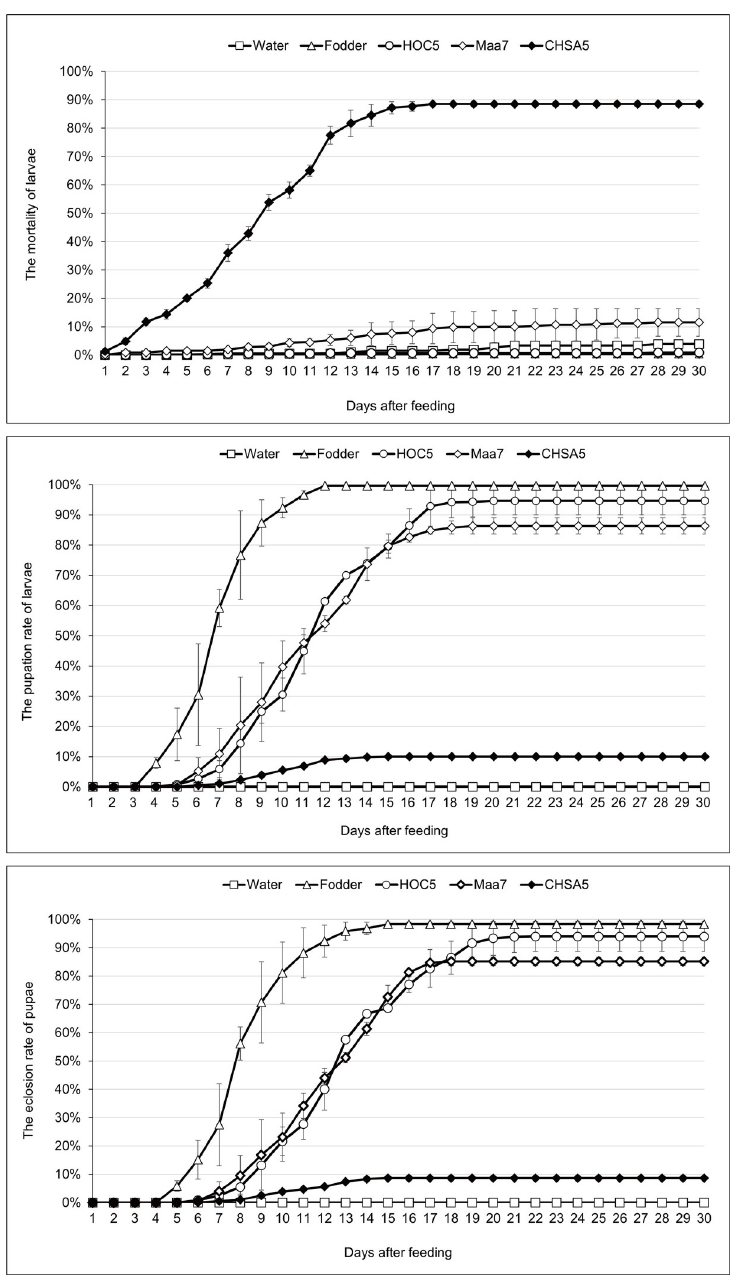
Fig 2. Mortality (A), pupation (B), and eclosion rates (C) of Aedes aegypti fed with chsa RNAi recombinant Chlorella . Water: larvae fed with water; Fodder: larvae fed with fodder; HOC5: larvae fed with wild Chlorella vulgaris HOC5; Maa7: larvae fed with empty plasmid Maa7IR/XIR transgenic Chlorella strain; CHSA5: larvae fed with recombinant Chlorella strain CHSA5. Each treated or control group contained 300 Aedes larvae, and the experiments were performed in triplicate for 30 days. 23.3% of the larvae died when fed on control Chlorella HOC5 or Maa7IR/XIR transgenic Chlo- rella , respectively (Fig 3A). In the 300 Ae . albopictus mosquito feeding experiment, 9.7% Aedes pupae emerged into adults when fed on recombinant Chlorella CHSA5. However, 93.8 and 88.7% of the control pupae emerged into adults within 30 days of feeding on fodder and